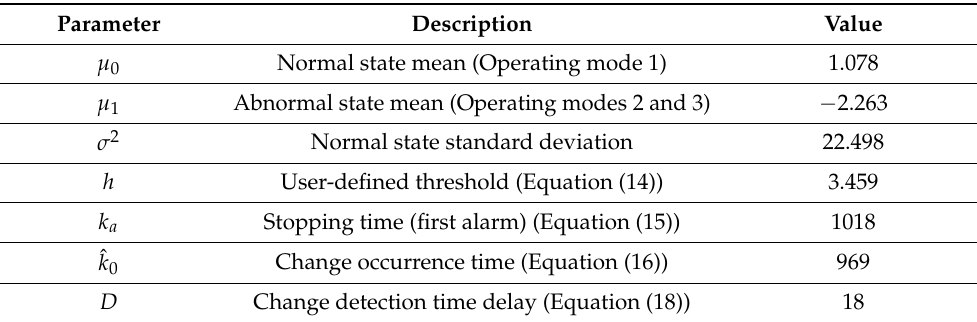
Table 9. Parameters description and performance monitoring results based on CUSUM